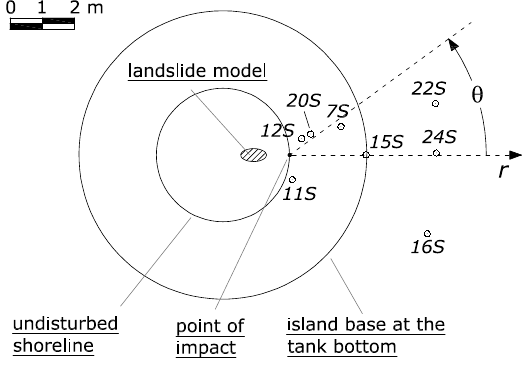
Fig. 2. Layout of the laboratory gauges positions.